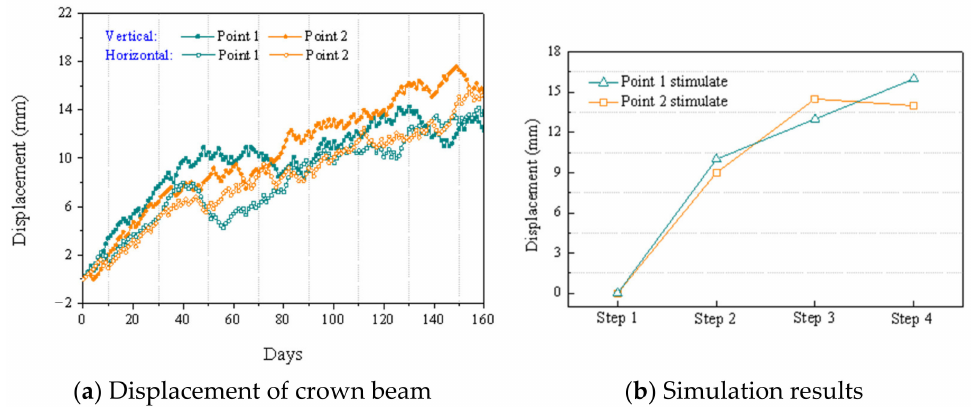
Figure 8. Horizontal and vertical displacement of the crown beam.